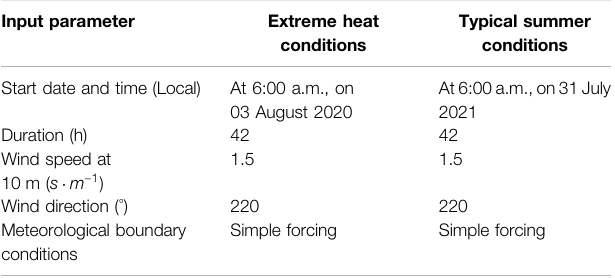
TABLE 2 | Simulation parameters of the three residential areas in ENVI-met